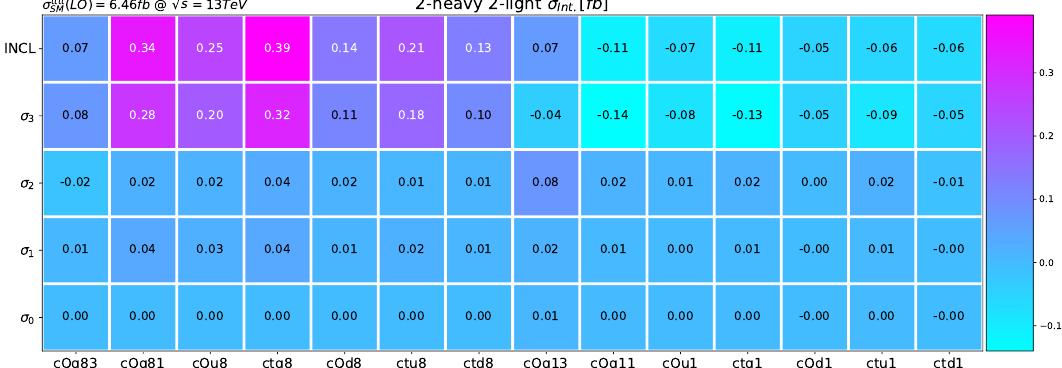
√ s = 13 TeV is presented for